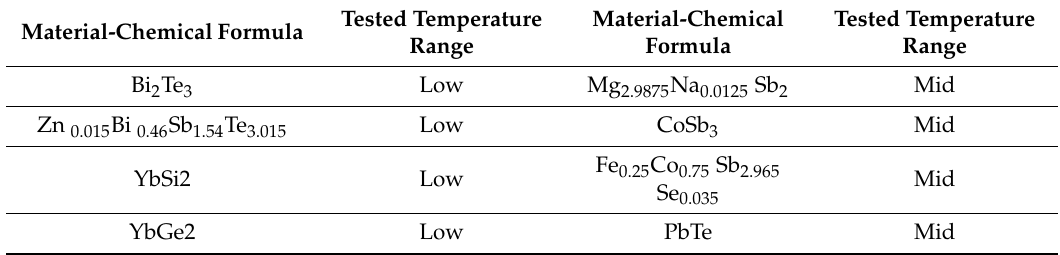
Table 2. The materials tested throughout the course of the